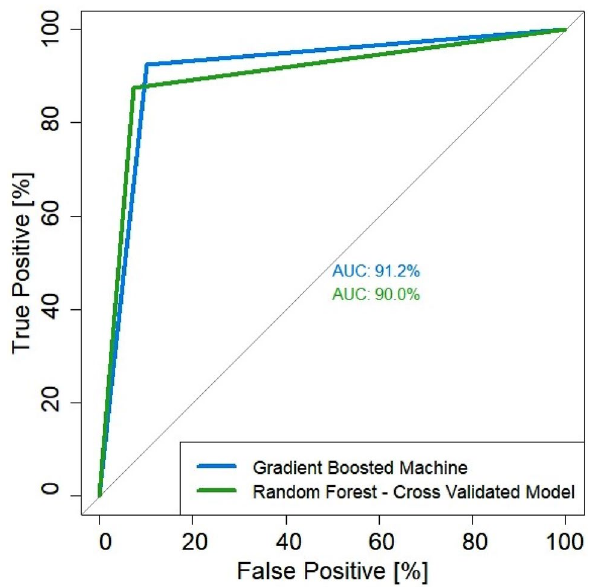
Figure 7. ROC curves with associated AUC values computed from Gradient Boosted Machine and Random Forest.